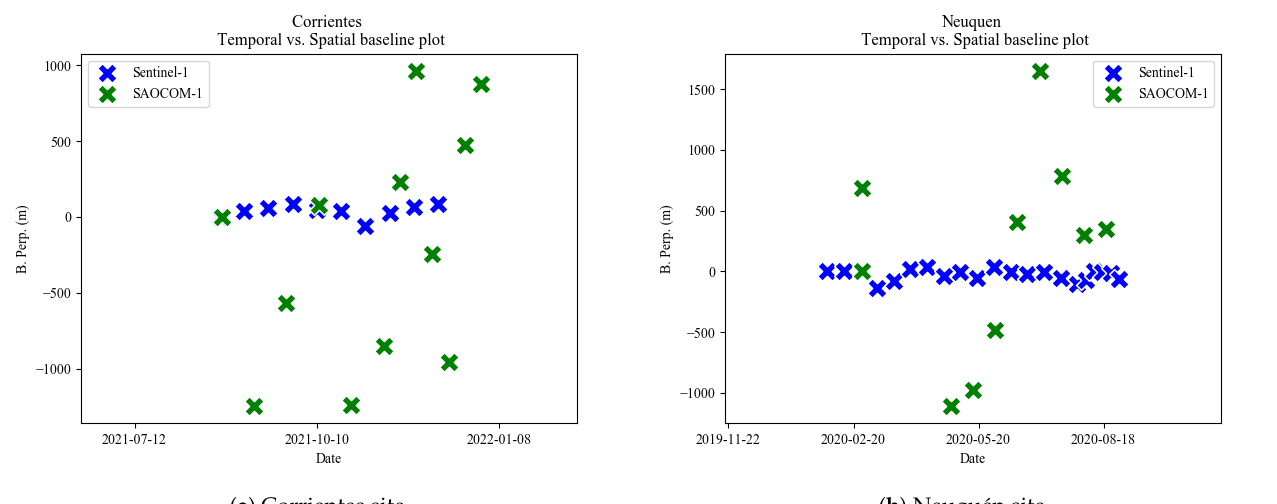
Figure 3. Spatial and temporal distribution of SAOCOM-1 and Sentinel-1